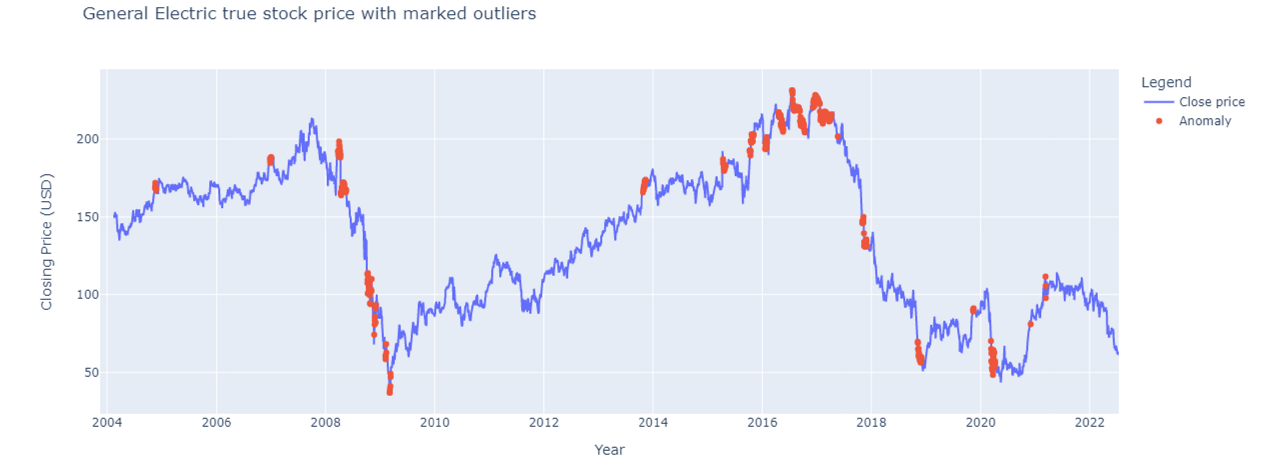
Figure A3. The ground truth stock price with the detected anomalies